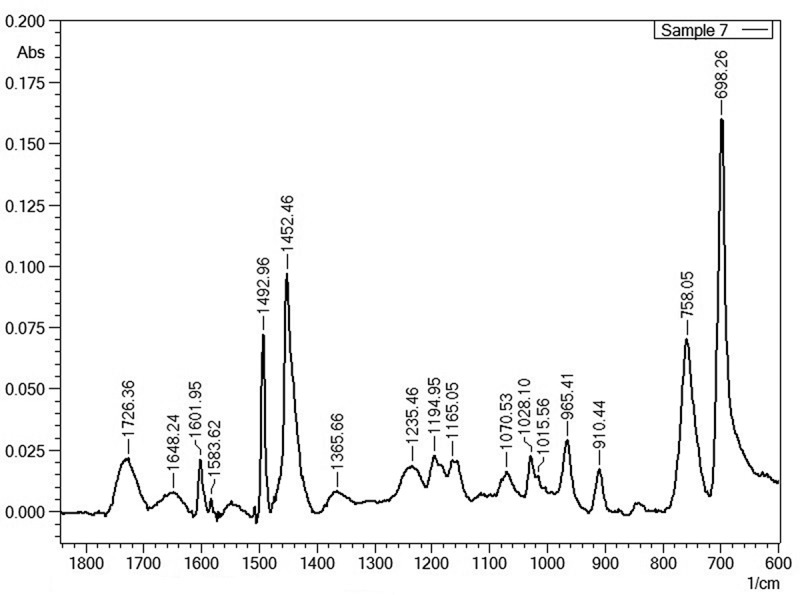
FTIR spectrum from sample 7 showing peaks from ABS (at 698.26, 758.05, 910.44, 965.41, 1028.10, 1452.46 and 1492.96 cm−1) as a majority with traces of polycarbonate (at 1015.56, 1070.53, 1165.05, 1194.95 and 1235.46 cm−1), traces of PP (at 1365.66 cm−1) and a weak ester peak at 1726.36 cm−1. This ester peak was confirmed by pyrolysis GC-MS belonging to methylmethacrylate from PMMA traces.